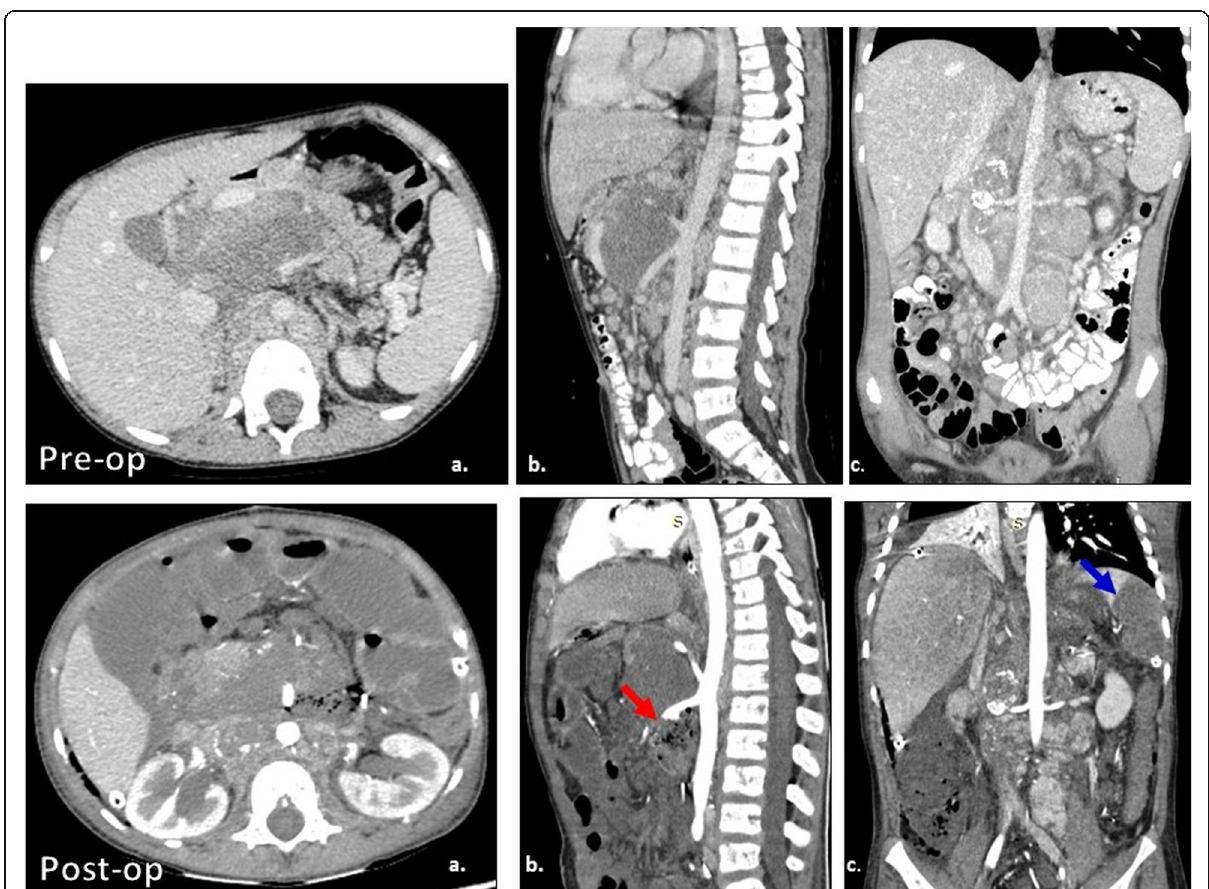
Table 5 Correlation between the pre-operative IDRFs and the surgical complications